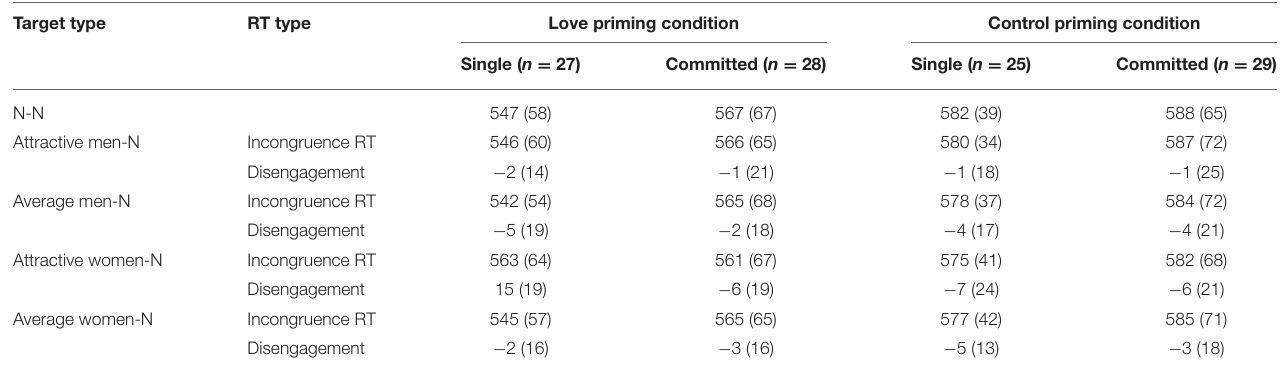
TABLE 1 | Mean RT (ms), disengagement indices and SD by target type, priming condition, and relationship status.